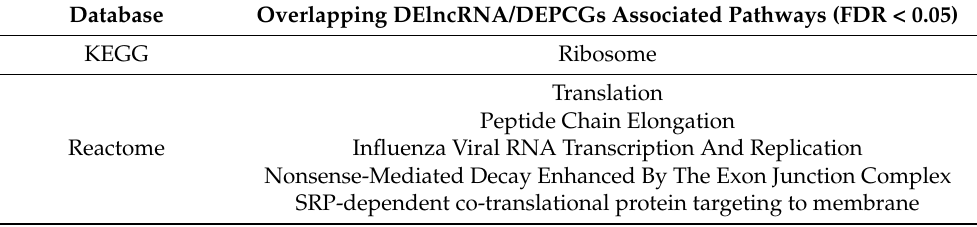
Table 2. Significantly enriched pathways associated with both DElncRNAs and DEPCGs (FDR < 0.05) as identified by LncPath R package and STRING database,